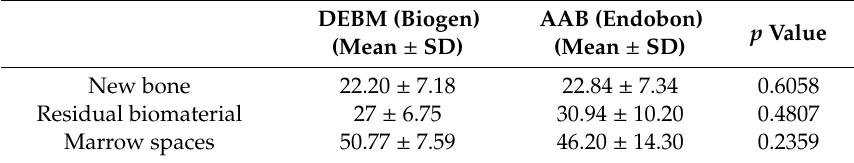
Table 1. Histomorphometric analysis: Mean and standard deviations of newly formed bone, residual biomaterial, and marrow spaces of the DEBM and AAB groups are shown. All values are expressed as